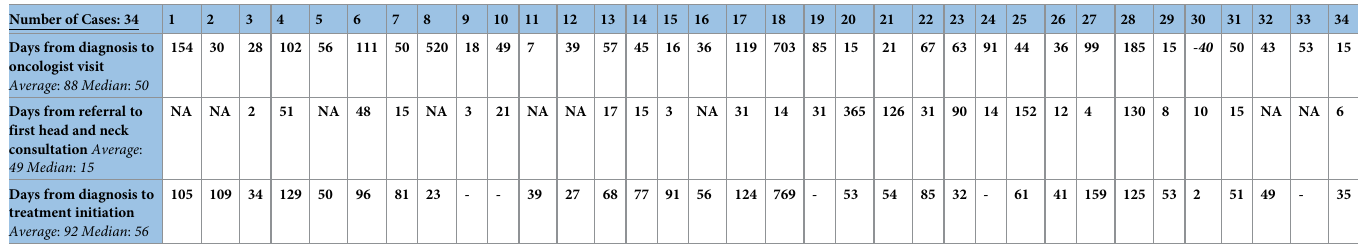
Table 4. Pre-treatment interval related data. NumberofCases:34